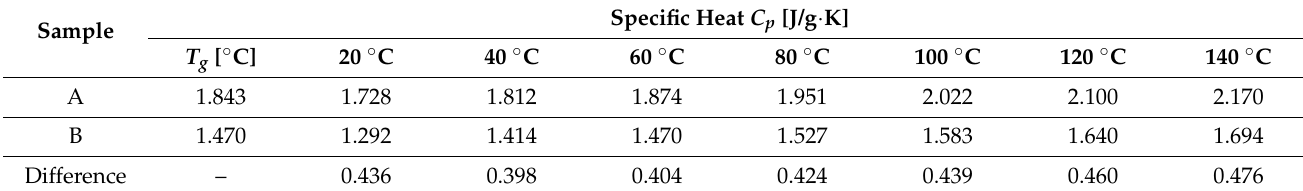
Figure 14. Dependence of specific heat capacity C p [J/gK] on temperature. Table 6. Specific heat analysis